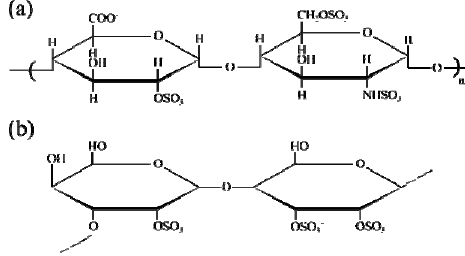
Figure 1. Chemical structure of anticoagulants: ( a ) Heparin; ( b ) Fucoidan.